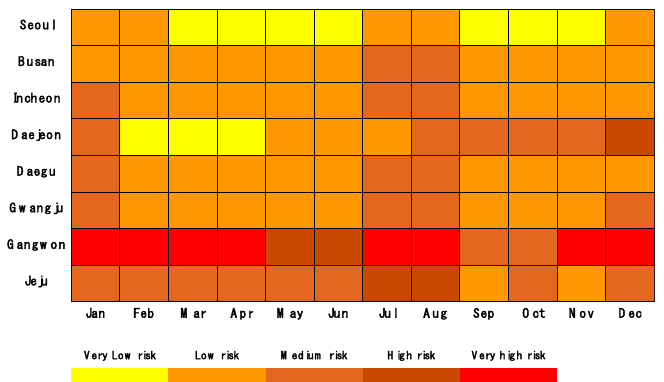
Figure 17. Risk matrix diagram for electrical fires by region and month.